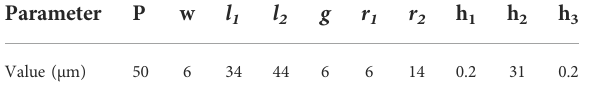
TABLE 1 The required dimensions of the suggested design.